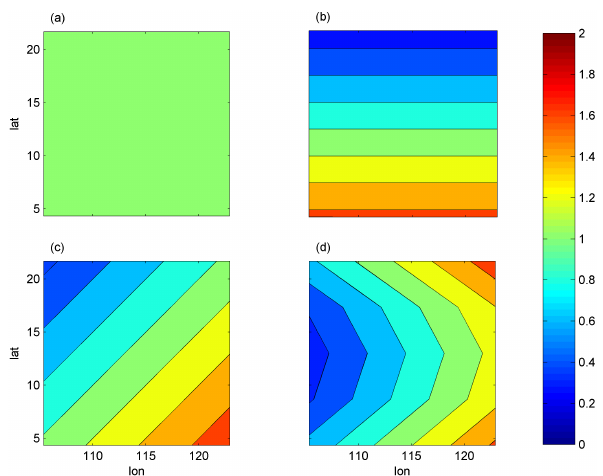
Figure 3. Spatial patterns of heat forcing Q for cases 1–4 (a–d) , units: Q 0